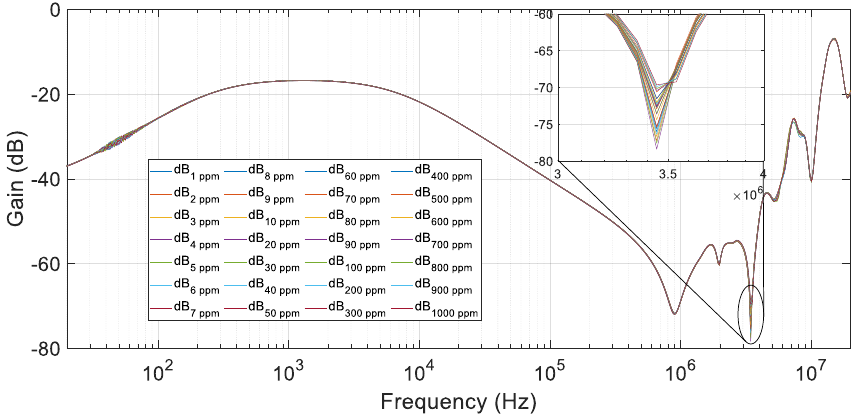
Figure 17. FRA test results for dissolutions of oil and water from 1 to 1000 ppm of water in oil.